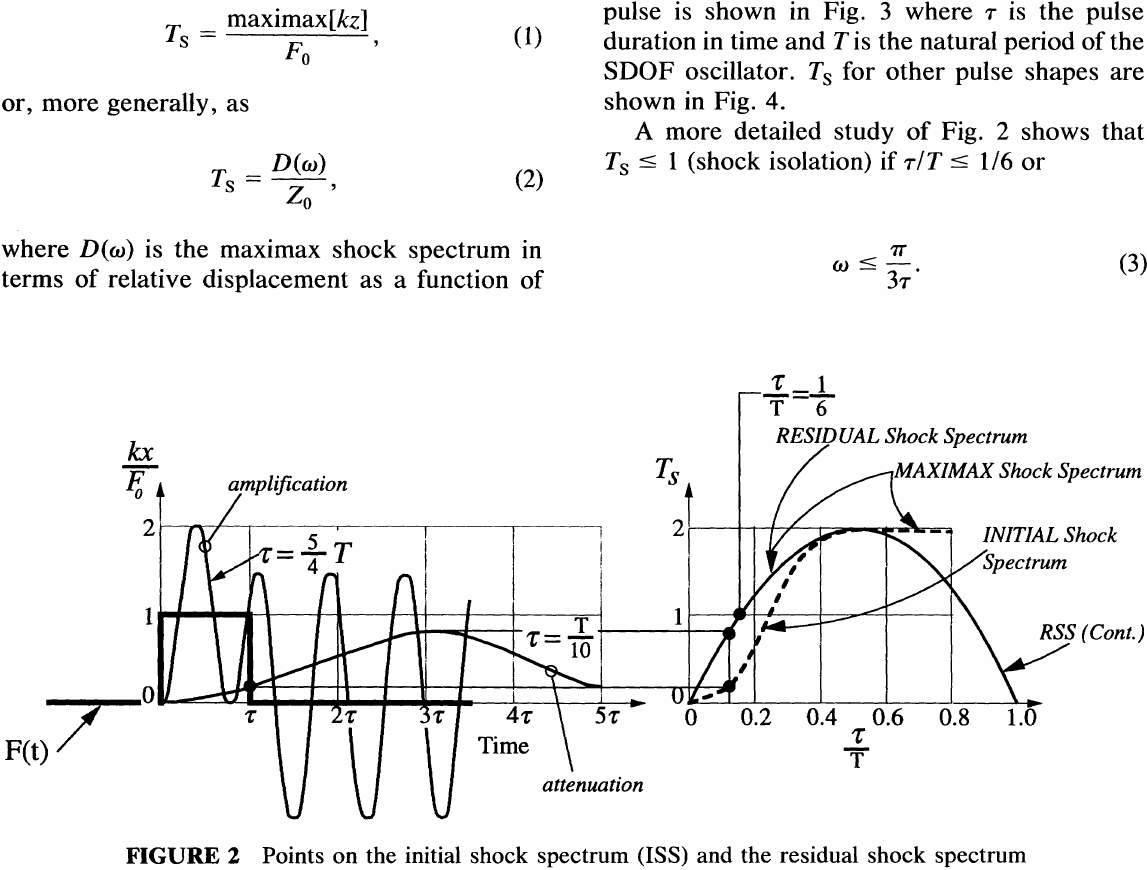
FIGURE 2 Points on the initial shock spectrum (ISS) and the residual shock spectrum (RSS) for TfT = 1110. Adapted from Norris et al.